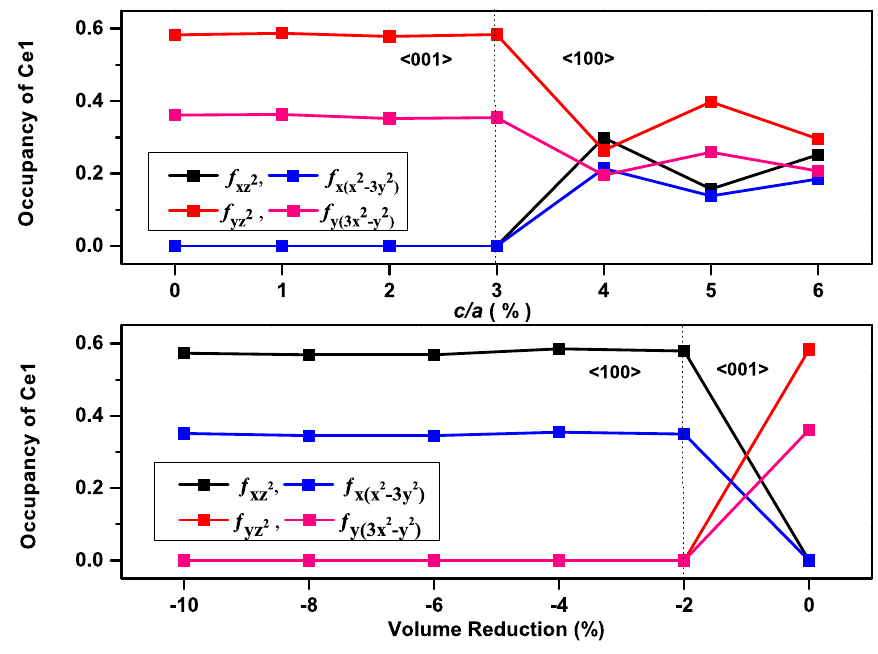
Figure 4. Occupancies of different 4 f orbital states’ number plots of the Ce atom with the magnetization along < 001 > for the CeAuSb 2 compound at constant volume (top) and a constant c / a ratio (bottom).